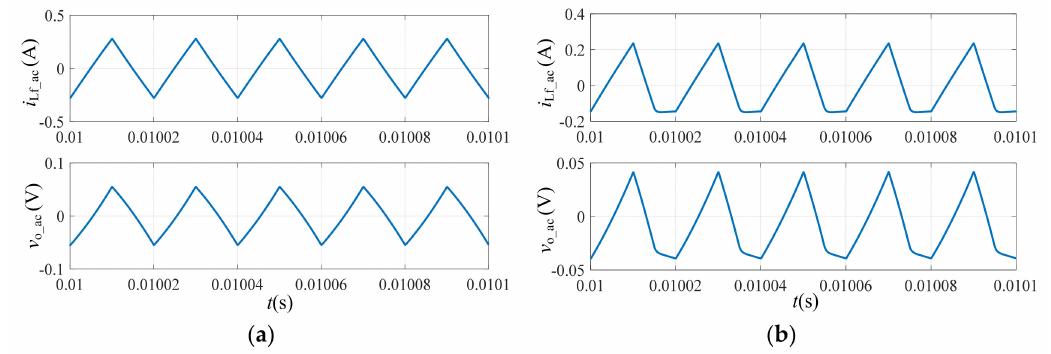
Figure 5. Simulation waveforms of Buck converter in ideal condition: ( a ) CCM; ( b ) DCM.